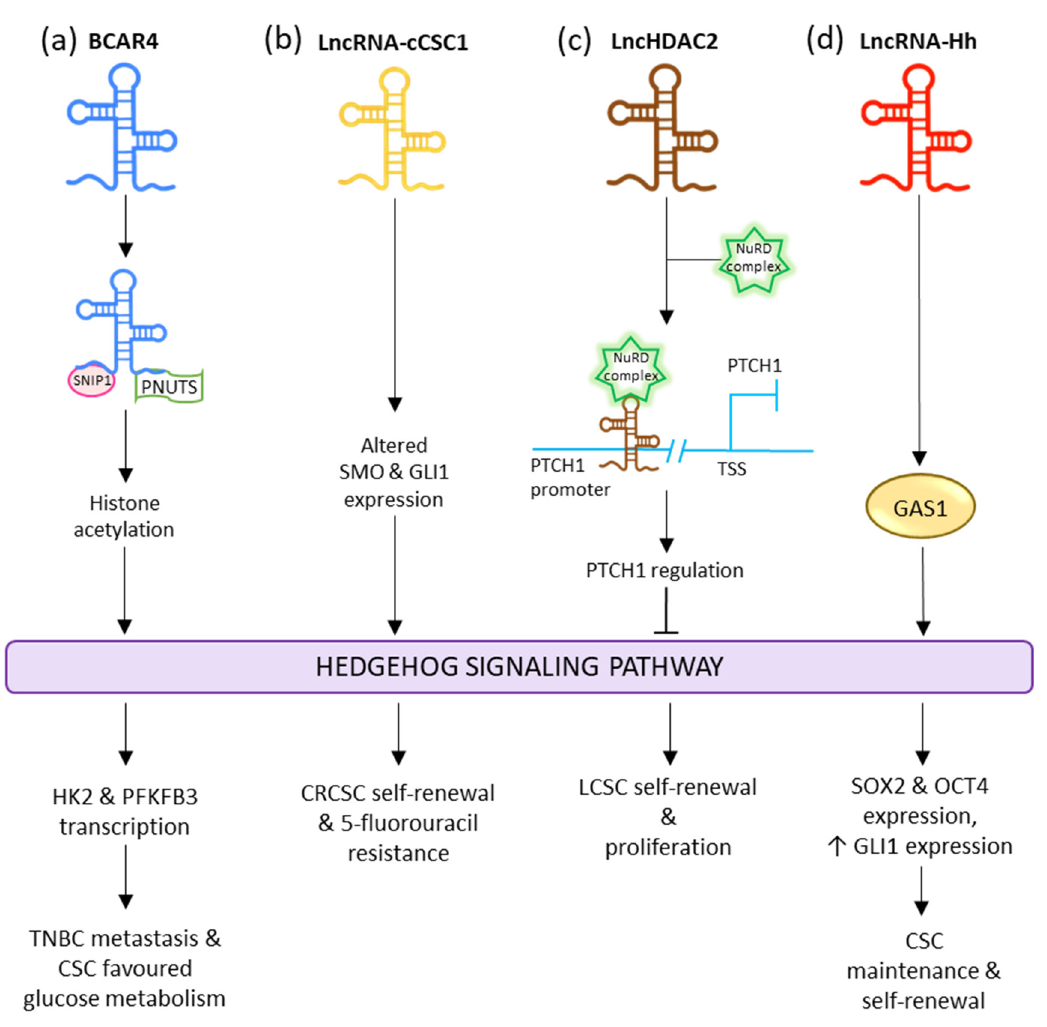
Figure 5. Influence of different lncRNAs on Hedgehog CSC signaling pathway.